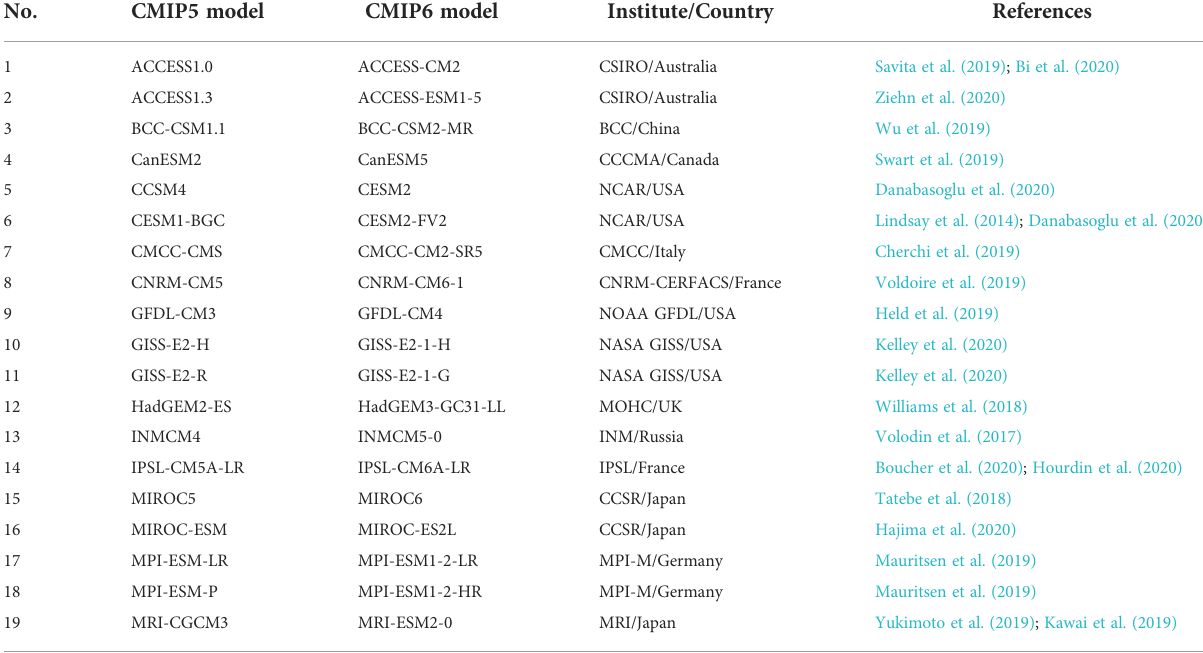
TABLE 1 List of models from the CMIP5 and CMIP6 analyzed in this study.